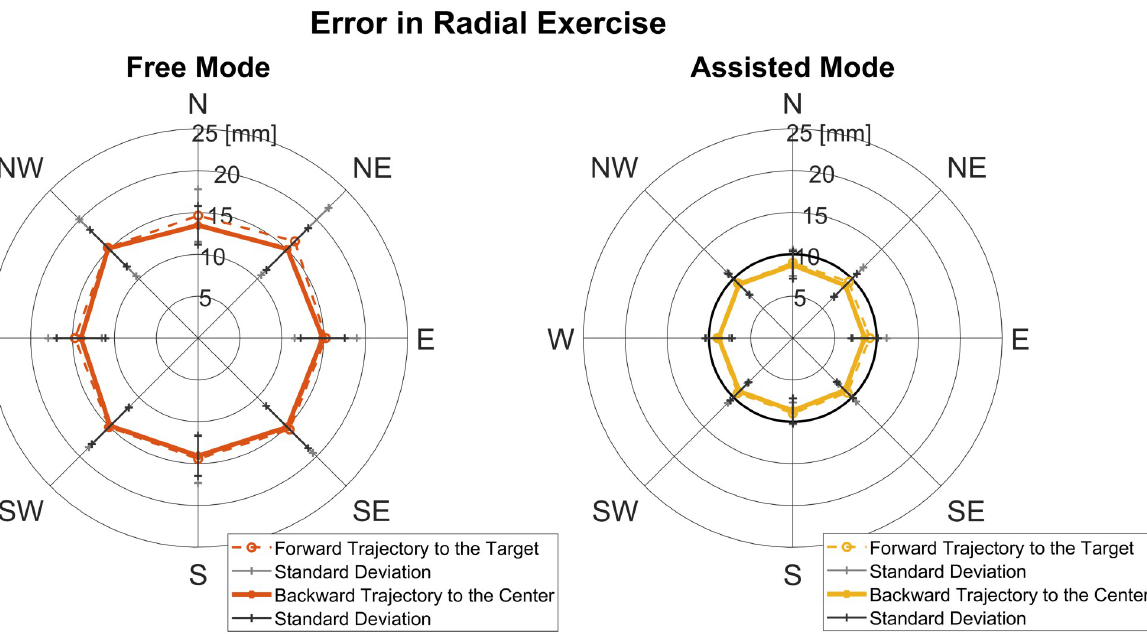
PLOS ONE | https://doi.org/10.1371/journal.pone.0272813 August 8,